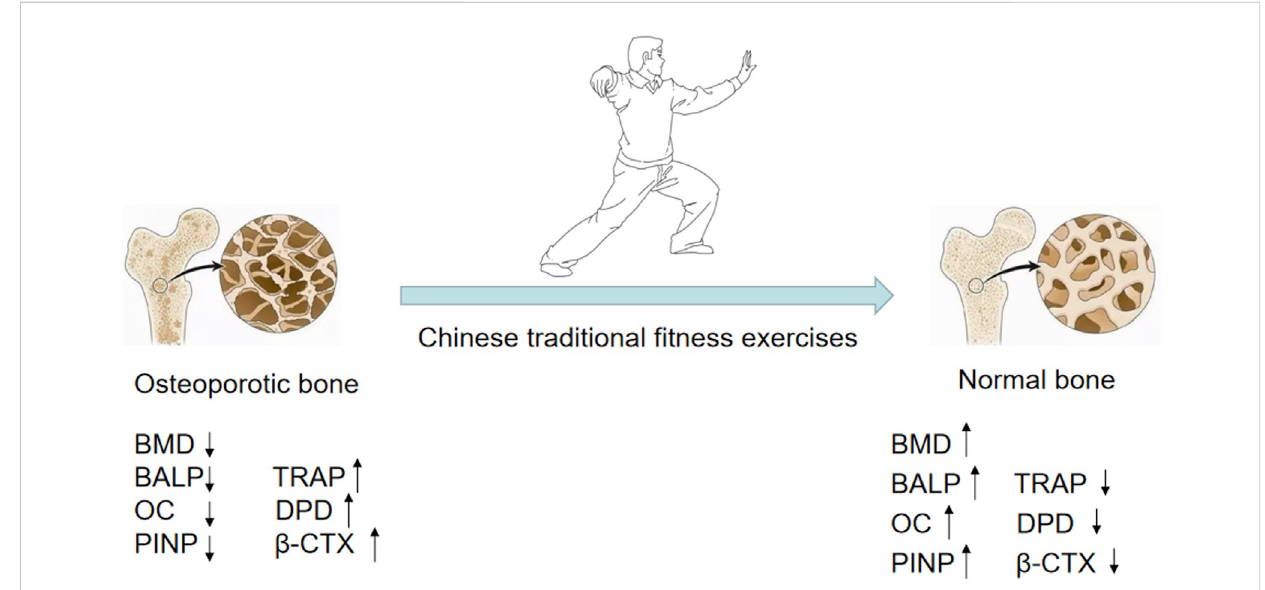
Chinese traditional fi tness exercises can strengthen the bone, improve bone density, and reduce bone